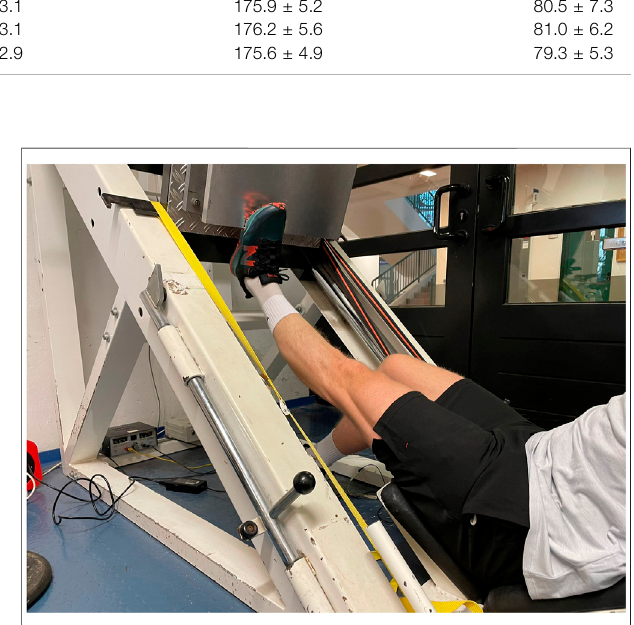
TABLE 1 | Characteristics of test subjects. Group